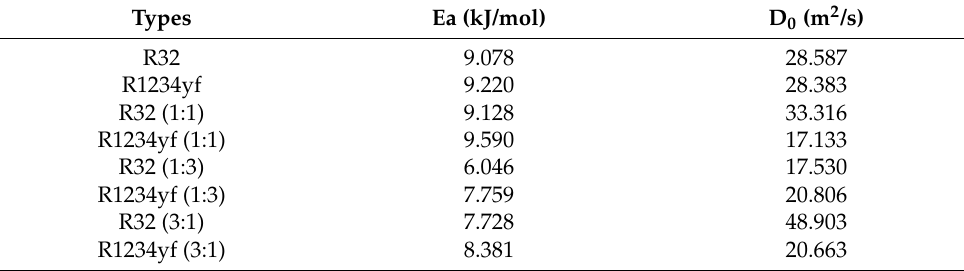
Table 5. Fitting results of R32/R1234yf diffusion activation